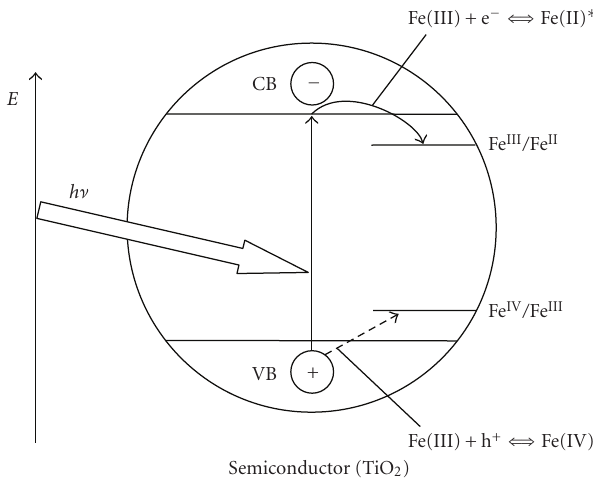
Figure 10: Scheme of mechanism of TiO 2 photocatalysis with modifications by Fe(III) ion doping (CB—conduction band, VB— valence